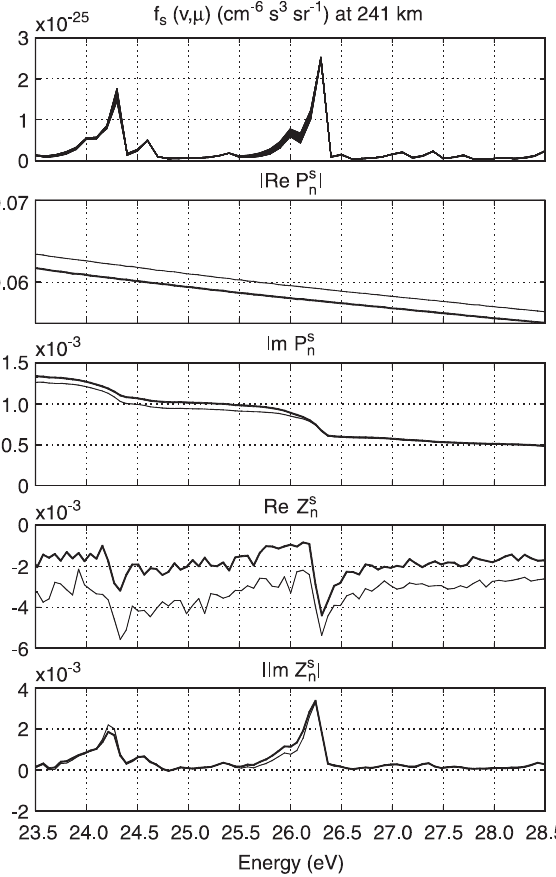
Fig. 8. The suprathermal electron angular velocity distribution function ( top panel ) at 241 km calculated by a 32-streams run of the transport code to gives the distribution at 32 angles and the complex functions P s and Z s calculated numerically with this distribution n n function, in the energy range 23.5–28.5 eV. The thin line is for downward phase energy and the thick line is for upward